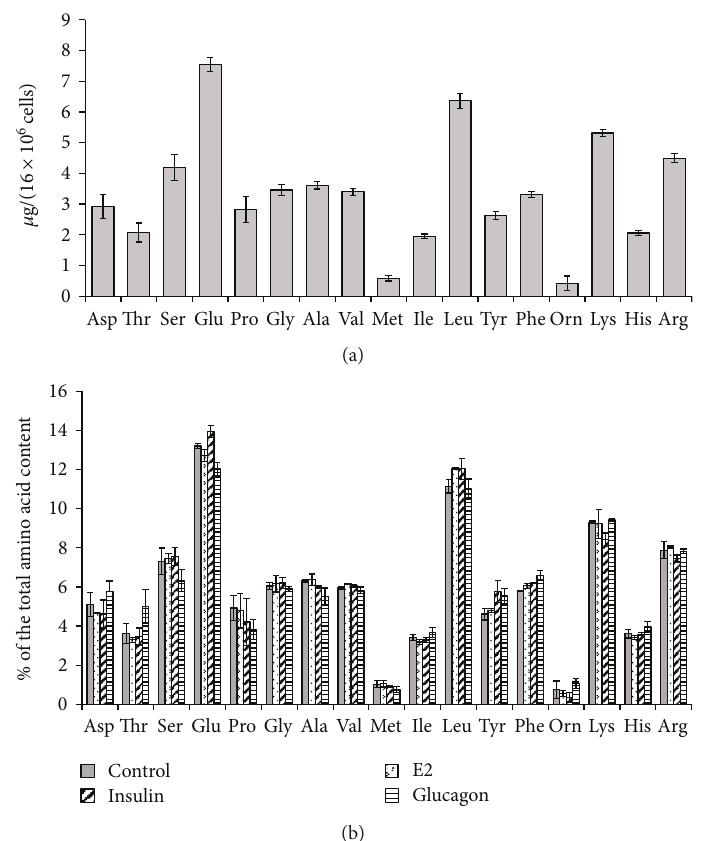
Figure 2: E ff ect of hormones on the amino acid composition of proteins secreted by neutrophils in adhesion to fi bronectin. Human neutrophils were attached to a substrate coated with fi bronectin for 20min under control conditions or in the presence of 0.1 μ M E2, insulin, or glucagon. The proteins were extracted from the extracellular medium, concentrated, and after acid hydrolysis subjected to amino acid analysis. (a) The amount of detected amino acids in the hydrolysate of proteins secreted by control neutrophils (mean ± SEM) is presented. (b) Comparison of the percentage of individual amino acids in hydrolysates of proteins secreted by neutrophils under control conditions and in the presence of hormones. Amino acid pro fi les were obtained by summing the results of three independent